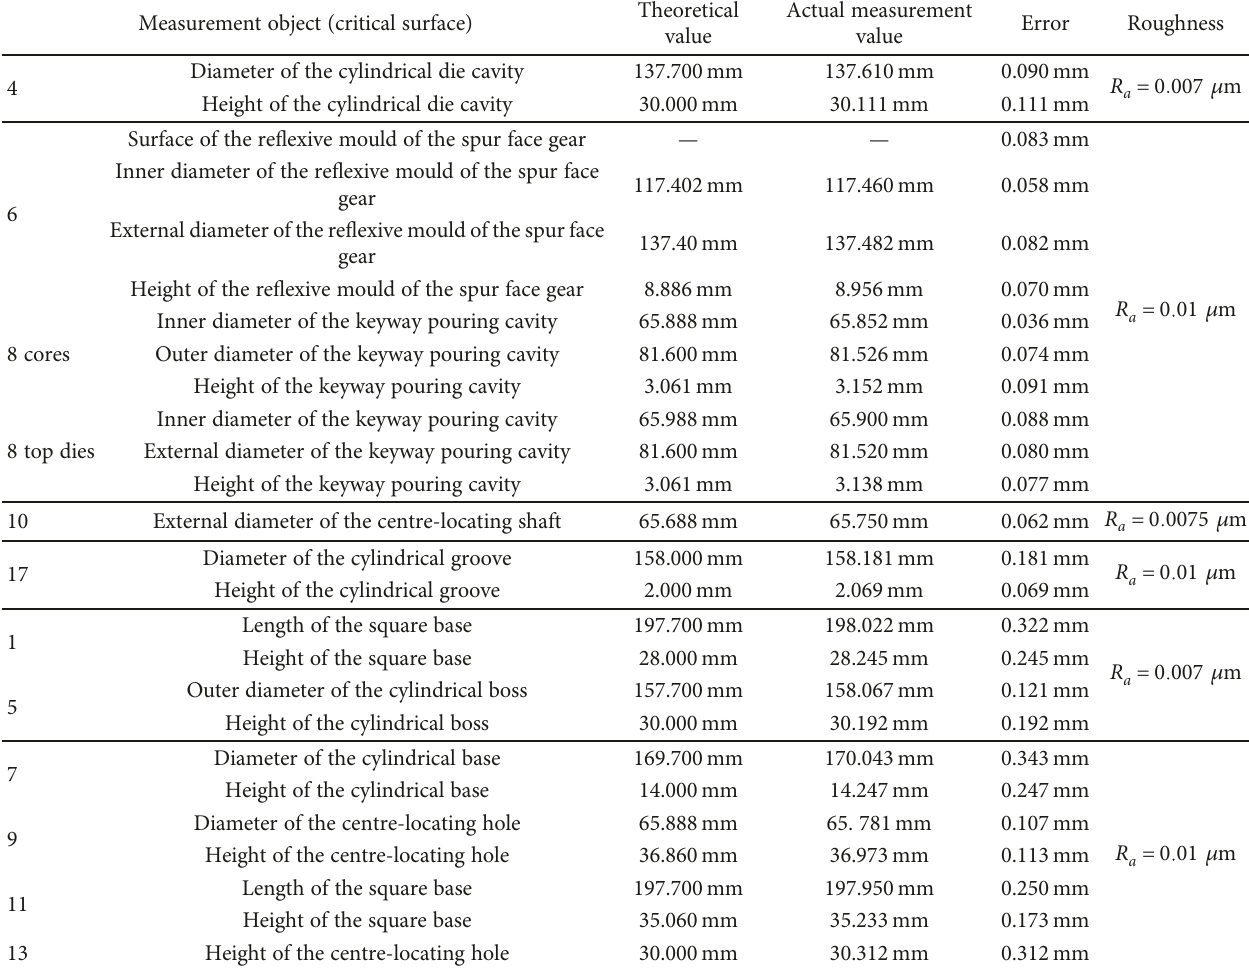
Table 7: The fi nal postprocessing results of the spur face gear master mould. Measurement object (critical